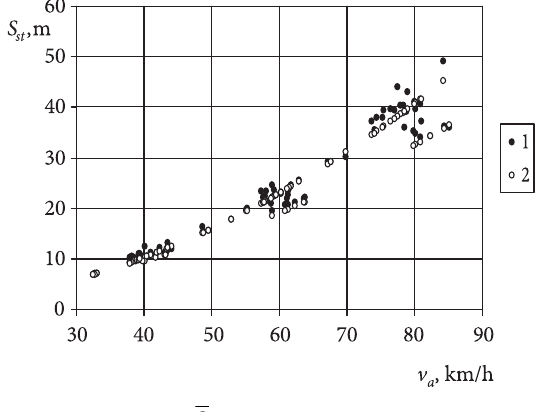
S values: 1 – experimental values; Fig. 8. Scatter of st 2 – prognosticated